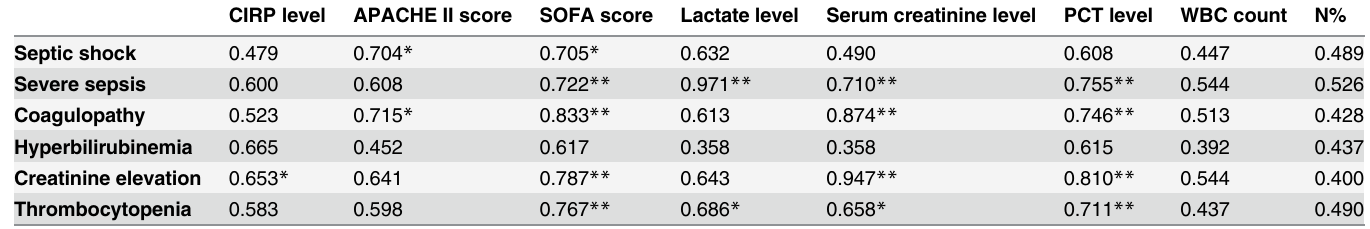
Table 5. Areas under the receiver operating characteristic curves for certain biomarker levels and the severity scores in the prediction of sepsis severity and organ failure in patients with